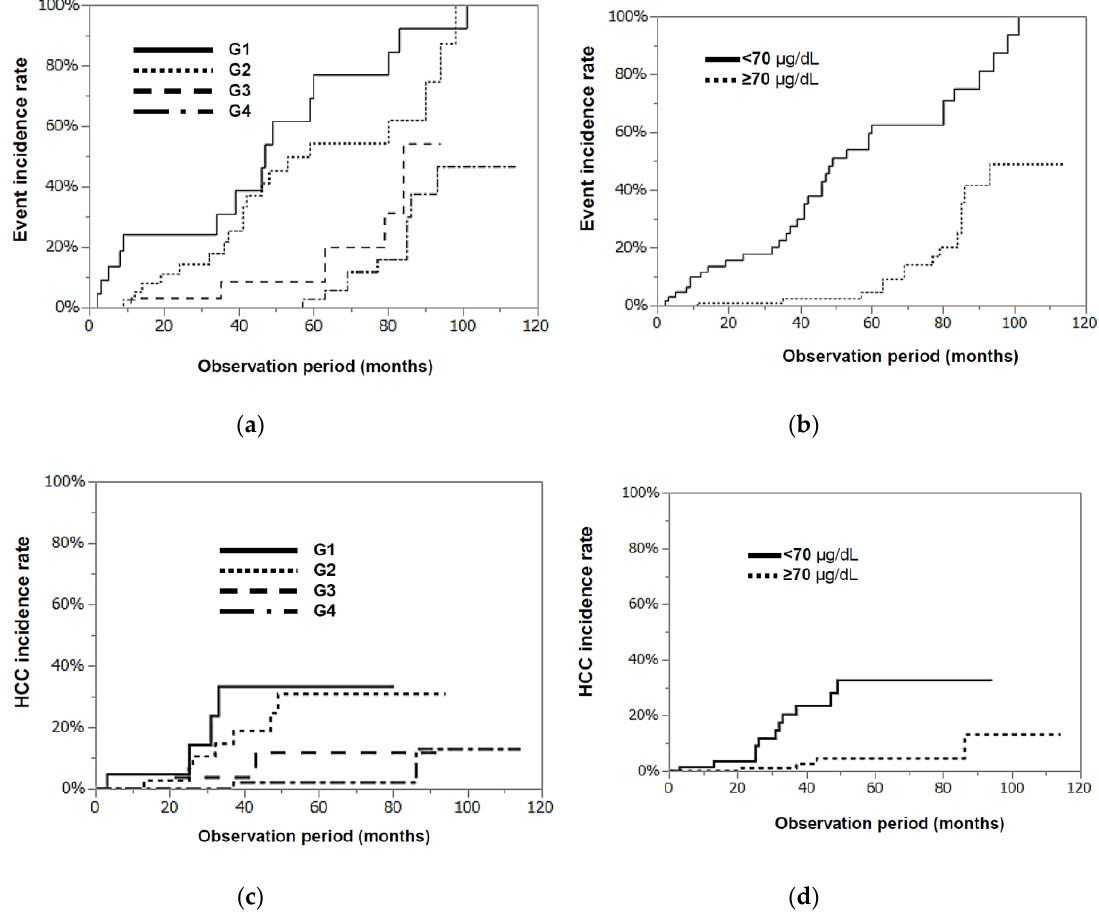
Figure 5. The cumulative incidence rates of events ( a ) and the incidence rates of HCC ( c ) in the 4 groups stratified according to their serum zinc concentrations measured 6 months after zinc administration — less than 50 µg/dL (G1), 50 – 69 µg/dL (G2), 70 – 89 µg/dL (G3), and not less than 90 µg/dL (G4). ( a ) G1/G2 groups vs G3/G4 groups, p < 0.0001, and ( c ) G1/G2 groups vs G3/G4 groups, ( p = 0.0007). ( b , d ) The cumulative incidence rates of events ( b ) and the incidence rates of HCC ( d ) in 2 groups stratified according to their serum zinc concentrations measured 6 months after zinc administration (less than 70 µg/dL (lower zinc group) and not less than 70 µg/dL (higher zinc group)); ( b ) p < 0.0001 and ( d ) p < 0.0001).